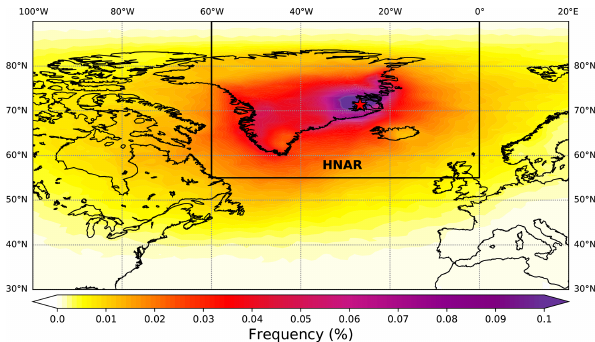
Figure 1. Seven-day back trajectories of years 2006–2019 at 500, 1000, and 2000m above Renland elevation, indicated as number of endpoints divided by number of trajectories. When more than one point of the same trajectory fall in the same grid cell, they are counted as one. The black box indicates the high North Atlantic region (HNAR), extending between 60–0 ◦ W in longitude and 90– 55 ◦ N in latitude. The red star indicates the Renland